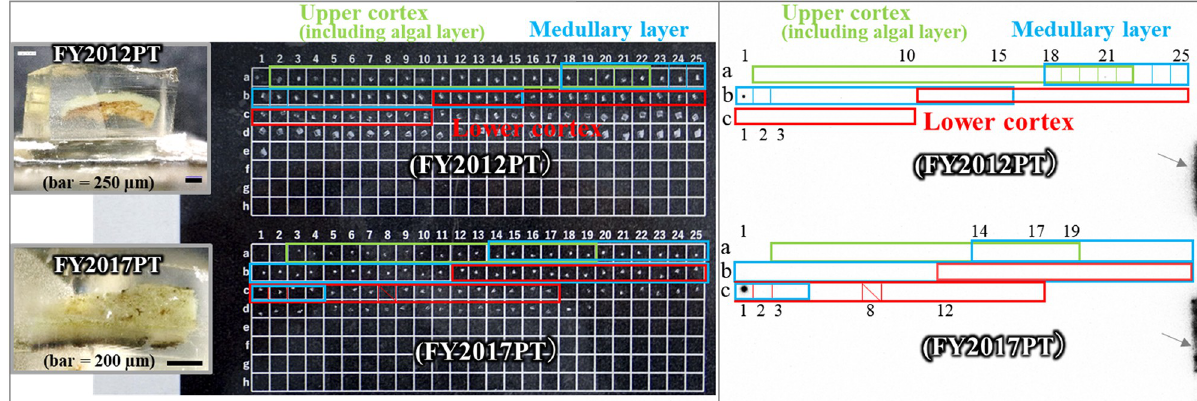
Fig 7. Radiocaesium distributions in the tissue sections of FY2012PT and FY2017PT selected from fragments showing spot distributions in Fig 2. The thallus tissues were prepared from the spot distributions “a” shown in Figs 1 and 2 for the FY2012PT and FY2017PT samples. Left panel: cross- sectional images of the FY2012PT (upper) and FY2017PT (lower) samples, as in Figs 3 and 5. Images of their tissue sections on the cell plate are also shown. Each tissue section was sliced from the surface side of the thallus tissue towards the lower cortex layer and laid on the cell plate in that order, the same as in Figs 3 and 5. Coloured frames are sections containing tissue. Green, aqua and red boxes indicate areas corresponding to the upper cortex (including the algal layer), medullary layer and lower cortex, respectively, which is also the case for the right panel. Overlapping boxes show that two layers were contained in an area. The sections were exposed for 24 hours on the IP. A shaded area, i.e., “c-8” in the FY2017PT plate, is missing a number. Right panel: autoradiograph images of tissue sections for the FY2012PT and FY2017PT samples. Spot distribution images were found in the “a-21” and “b-1” layers of the FY2012PT sample and in the “c-1” layer of the FY2017PT sample. Grey arrows indicate marks used to determine the location of the cell plate boxes.